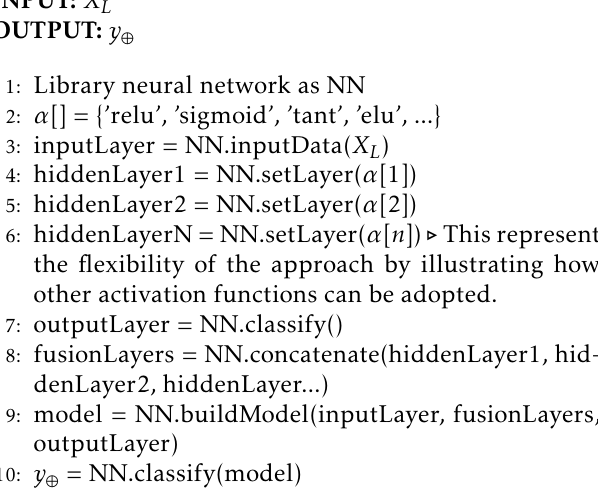
Algorithm 1 Model building algorithm utilising fusion activation functions for activity